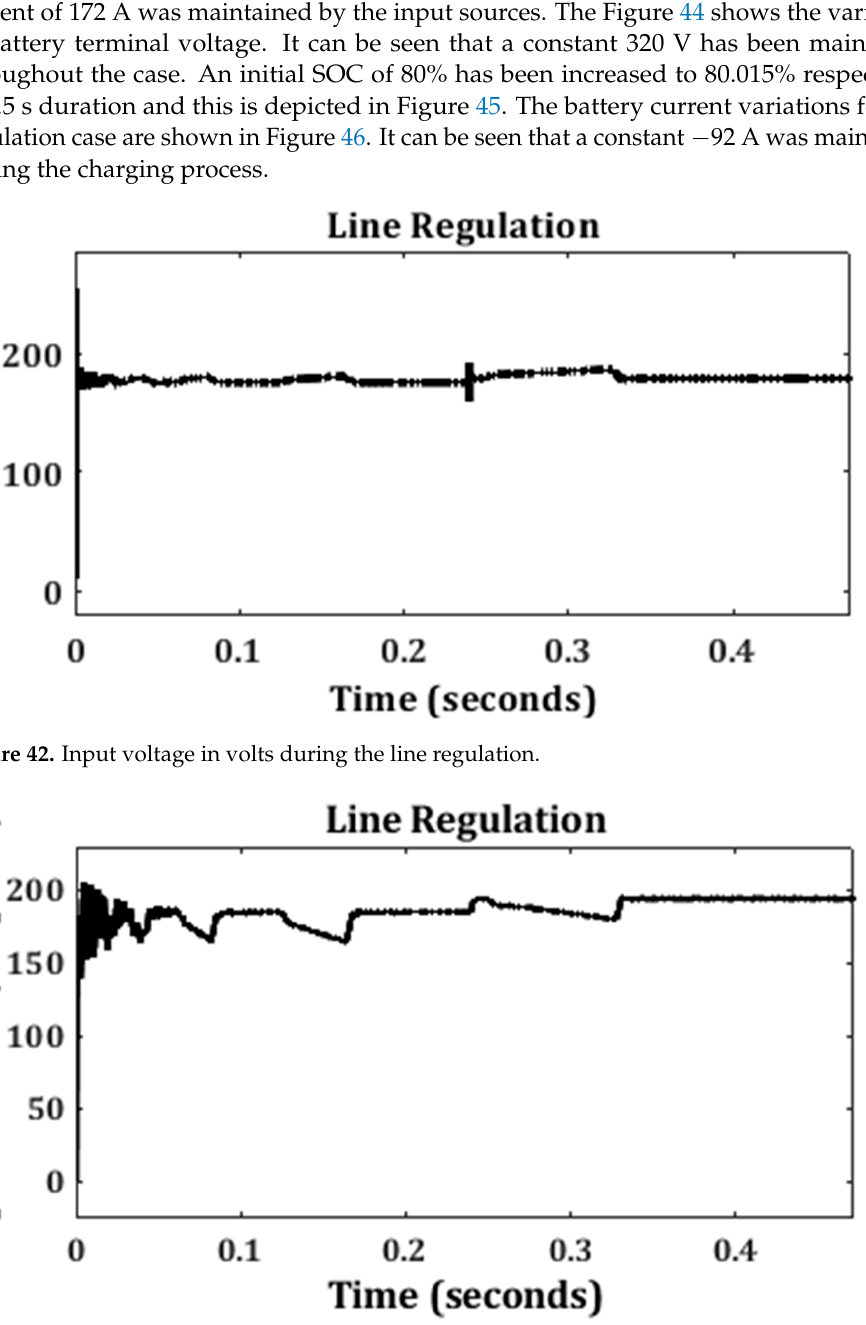
Figure 44. Battery terminal voltage in volts. Figure 45. State of charge in %.